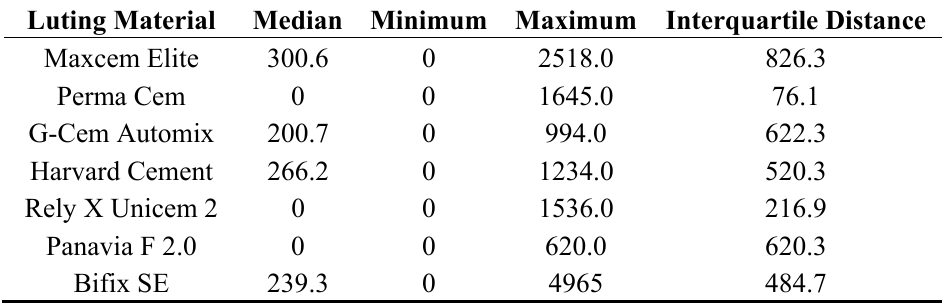
Table 4. Descriptive data of the statistical evaluation of microleakage in enamel in μ m.